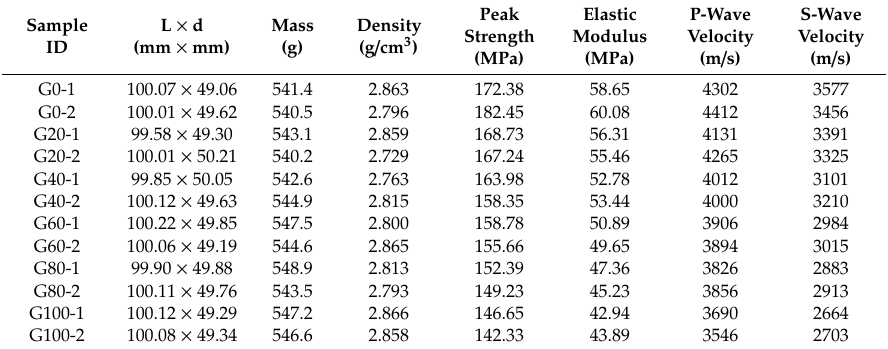
Table 1. The basic mechanical and physical parameters of the granite samples subjected to freeze–thaw (F–T) treatment.